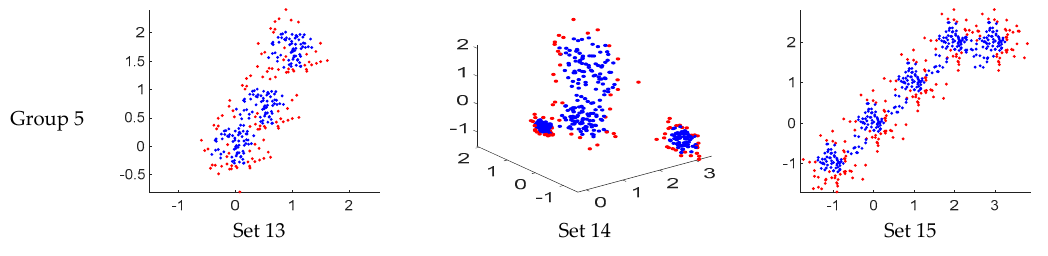
Figure 8. Five groups of synthetic datasets.